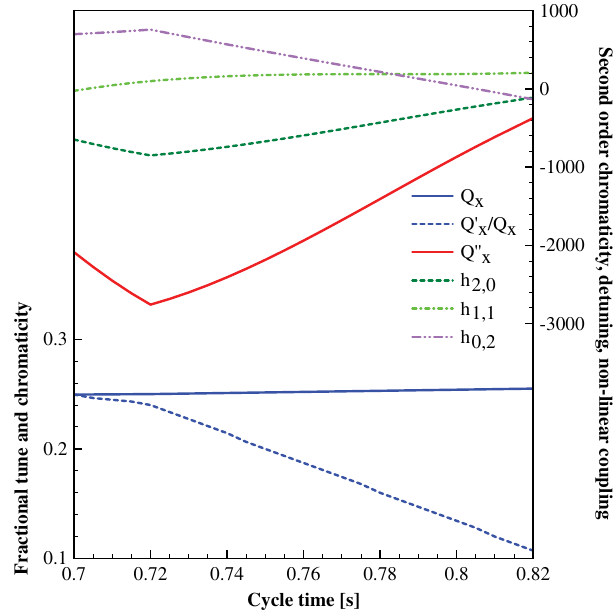
FIG. 4. Overview of the time evolution of the main physical parameters during the transverse splitting together with the horizontal tune and the linear and second-order chromaticity. The time span corresponds to the shadowed area of Fig.